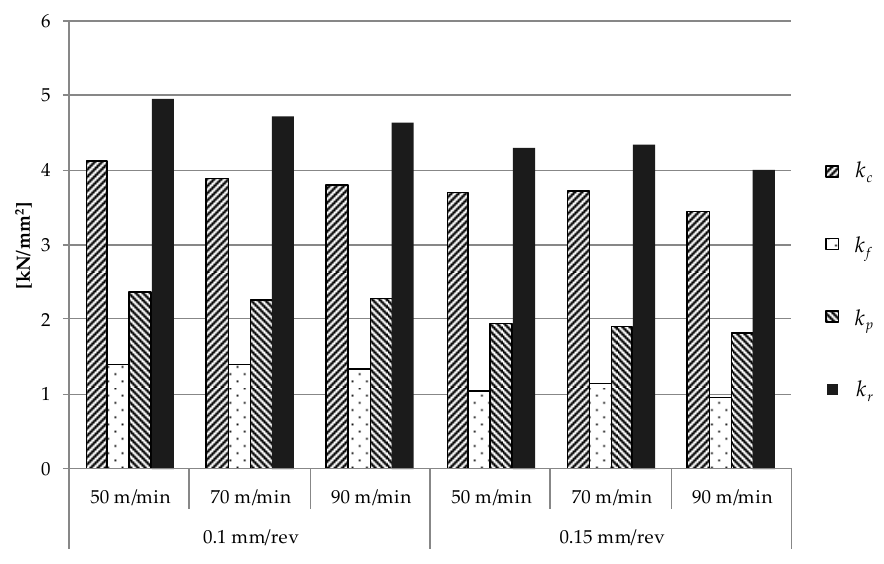
Figure 2. Initial specific cutting forces for the carbide tools.